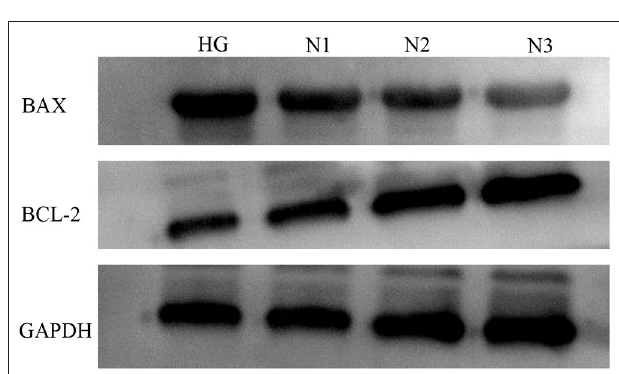
FIGURE 2 | Apoptotic protein expression levels in H9c2 cells in each group. The electrophoresis of apoptosis-related proteins in each group.